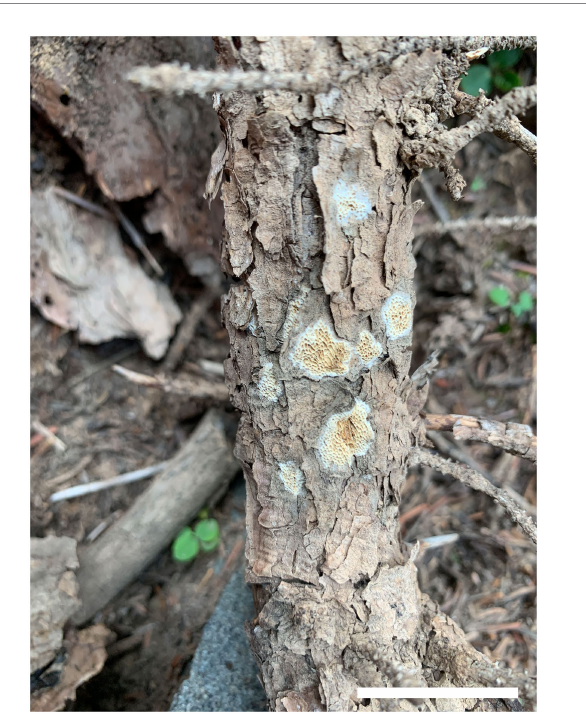
FIGURE 2 Basidiocarps of Antrodia aridula (holotype, Dai 24525). Scale bar: 2 cm.